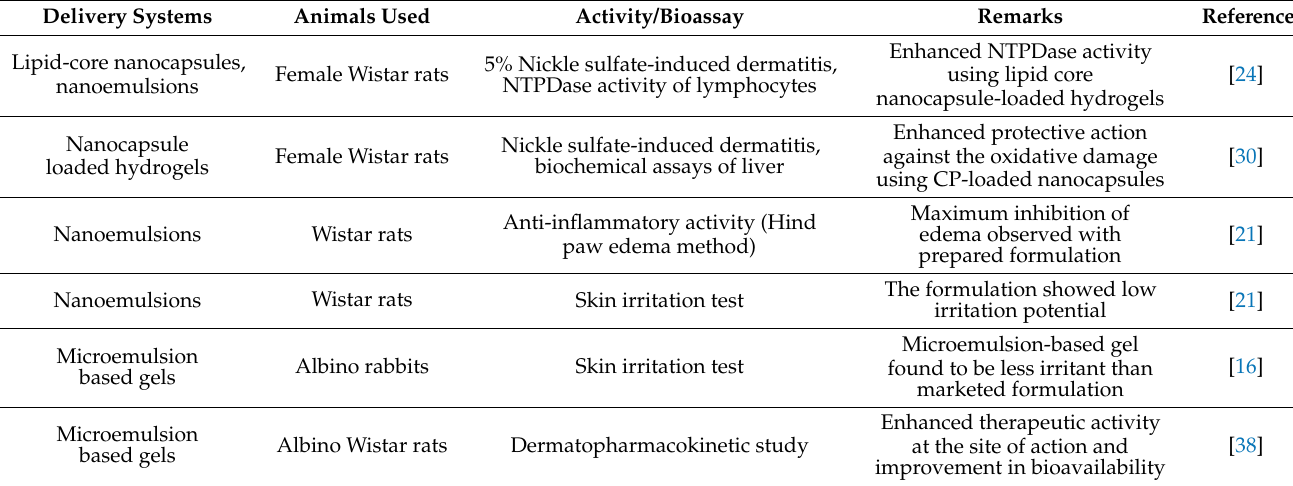
Table 3. In vivo studies of novel cargos of clobetasol